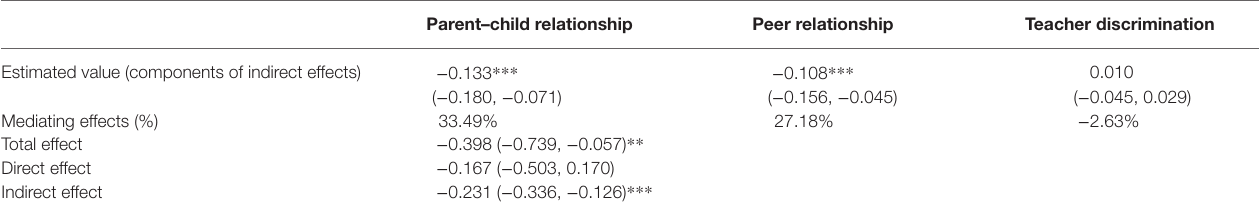
TABLE 6 | Mechanism analysis using the Karlson–Holm–Breen (KHB)